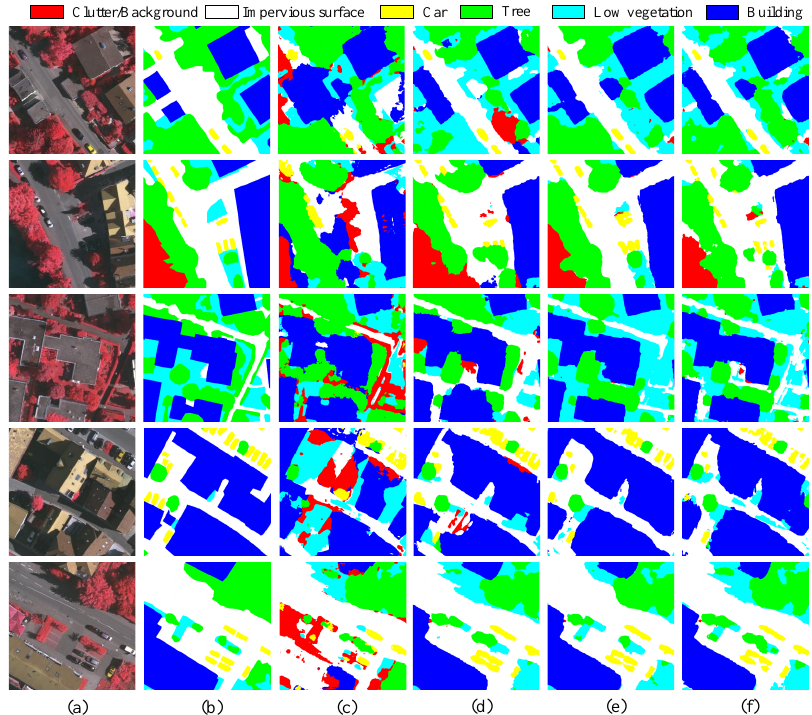
Figure 5. Qualitative results of cross-domain semantic segmentation on Potsdam RGB → Vaihin- gen IRRG. ( a ) Target images. ( b ) Ground truth. ( c ) Baseline. ( d ) CSC-Trans. ( e ) CSC-Aug and ( f ) CSC-CutMix.